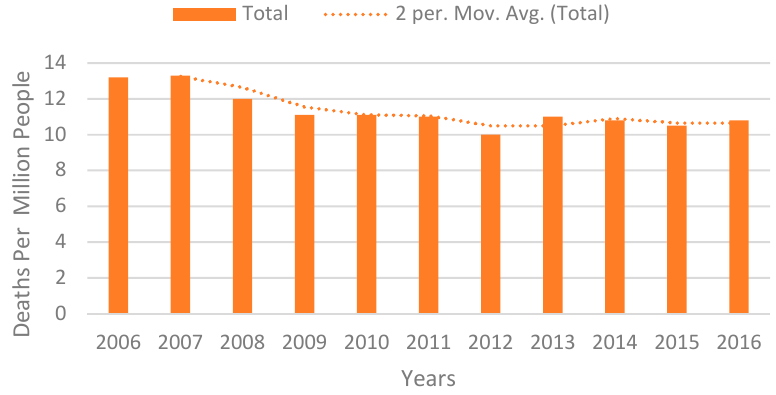
Figure 2. Fire deaths per million people.